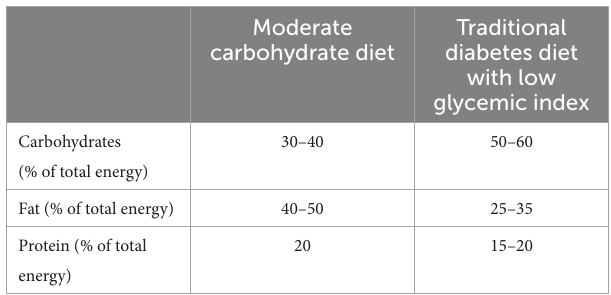
TABLE 2 Macronutrients in the two intervention